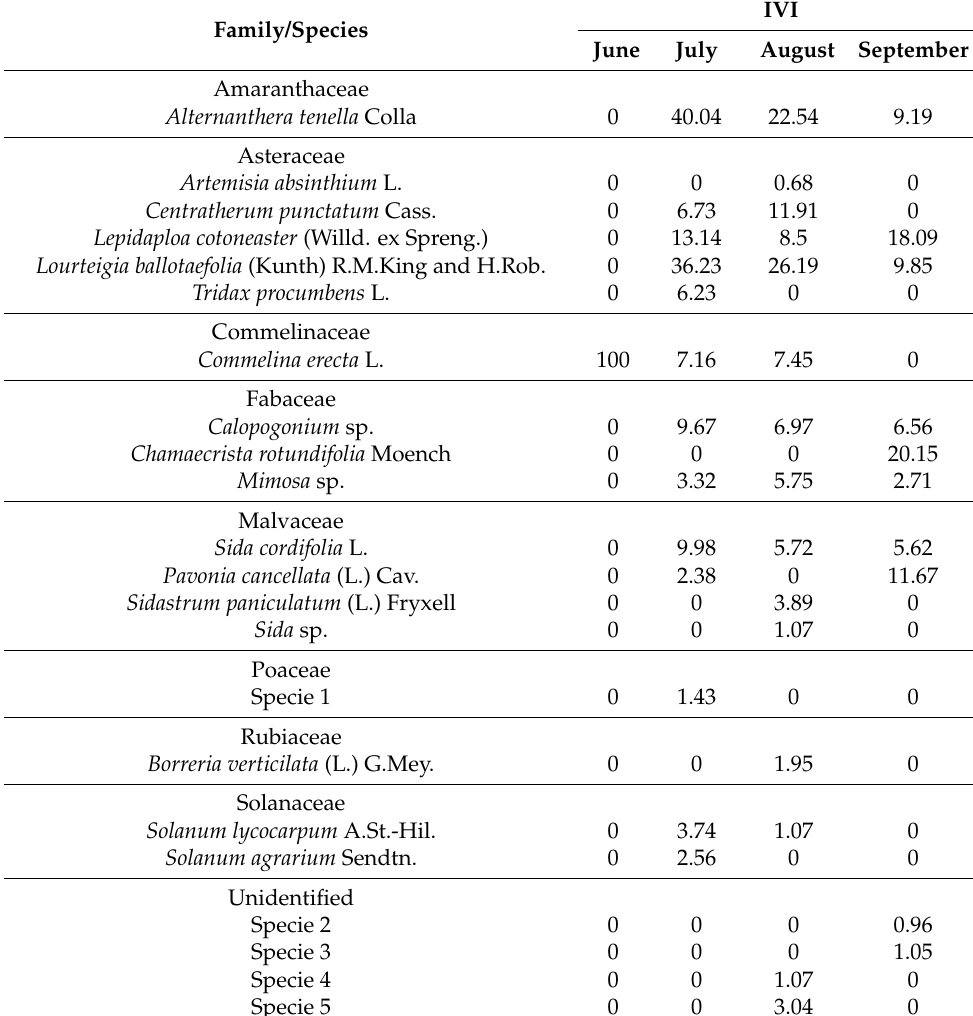
Table 1. Plant importance value index (IVI) collected from June to September 2015 in a sisal